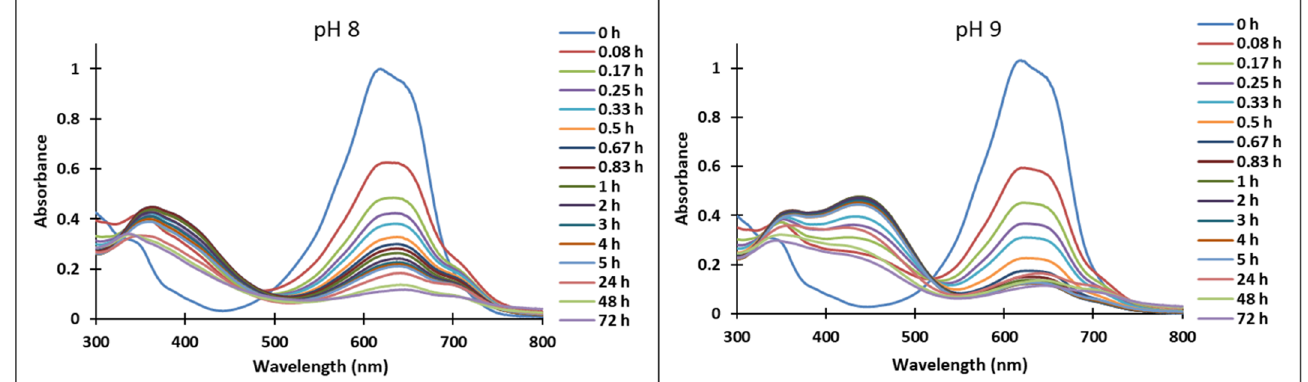
Figure 7. Absorption spectra of the species derived from compound 4 in time at pH 8, respectively pH 9.